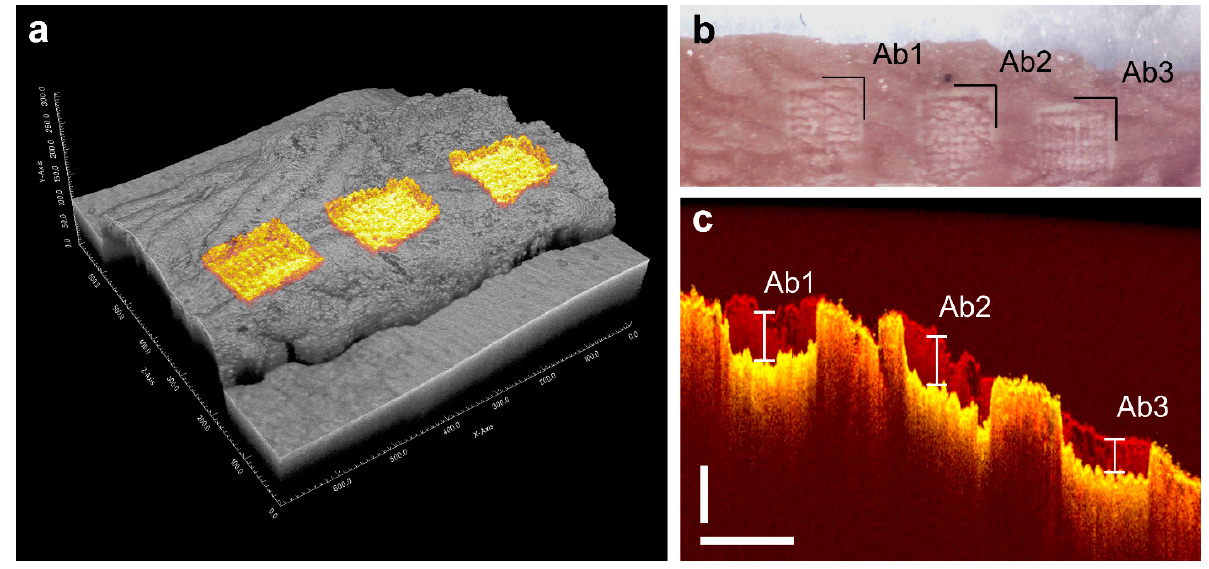
Figure 5. ( a ) Three-dimensional reconstruction of the two registered OCT volumes before and after the laser ablation, with the ablation surfaces highlighted in yellow. ( b ) Picture of the murine colon after the ablation of 2 layers at three positions along a line. ( c ) Example OCT brightness scan (B-scan) of the two registered volumes before (red) and after (yellow) ablation with depth measuring markings for the three ablations Ab1, Ab2, and Ab3. Scale bars measure 250 µ m vertical and 500 µ m horizontal,